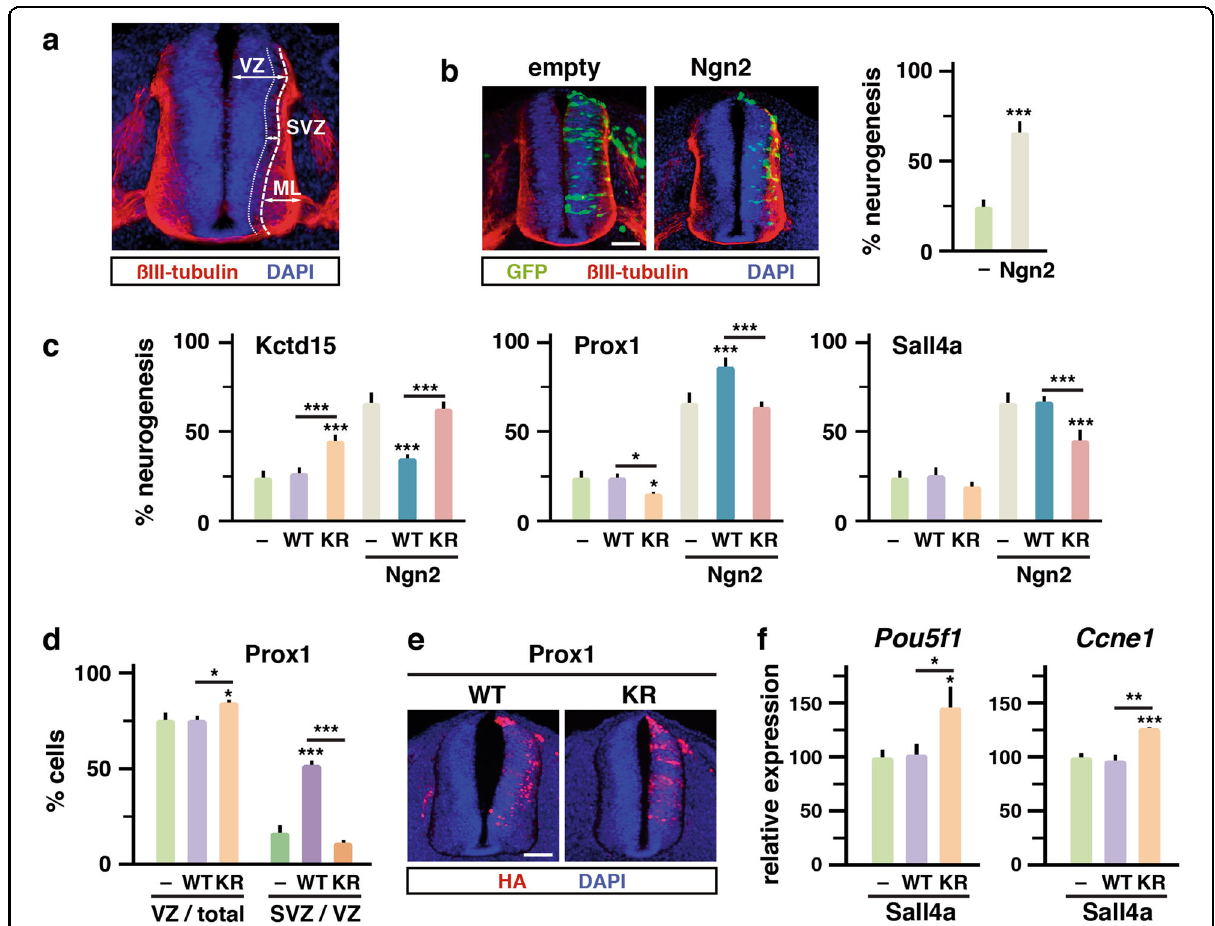
Fig. 4 Kctd15, Sall4a, and Prox1 display altered effects in the neural tube when mutated for sumoylation. a Section of the developing neural tube indicating the limit between the proliferative ventricular zone (VZ) and the differentiation mantle layer (ML). The subventricular zone (SVZ) of migrating early postmitotic neurons at the pial surface of the VZ is also indicated. The ML-associated neuronal marker β III-tubulin (red) and DAPI- stained nuclei (blue) are shown. b About 65% of neurogenesis is achieved in the developing neural tube after forced expression of the neurogenic factor Neurogenin 2 (Ngn2) for 30 h, in comparison with 25% of naturally occurring neurogenesis when the empty vector is electroporated ( – ). Neurogenesis was determined in immuno fl uorescence experiments by the percentage of transfected cells (GFP positive, green) located in the ML. c Effect on neurogenesis of WT or KR versions of the indicated proteins, in the absence (empty) or the presence of Ngn2. Controls ( – ) correspond to the percentages of neurogenesis in the absence (empty) or the presence of Ngn2 as determined in ( b ). d The percentages of control cells (empty vector electroporation), and of cells expressing WT or KR Prox1 in the absence of Ngn2, localizing to the VZ in relation to the total number of transfected cells, and localizing to the SVZ in relation to the cells localizing to the VZ, were represented. e Localization of expressed HA-tagged WT or KR Prox1 was analyzed by immuno fl uorescence with anti-HA antibodies (red). Nuclei were visualized by DAPI staining (blue). Scale bars 50 µm. f Expression of Pou5f1 and Ccne1 was assessed in P19 cells by quantitative PCR under proliferation conditions in the absence ( – , empty vector) or the presence of expressed WT or KR versions of Sall4a. Represented values are means ± s.d. from counting 150 cells in fi ve sections from three independent experiments ( b – d ) or from three independent experiments analyzed in triplicate ( f ). Statistical signi fi cance in relation to the control is indicated on top of each bar, other comparisons are indicated with a line. Statistical signi fi cance was determined by ANOVA ( p < 0.0001), followed by Bonferroni ’ s post-test (95% con fi dence intervals) ( c , d ) or by the Student ’ s t test. * p < 0.05, ** p < 0.01**, and *** p < 0.001 ( b , f ).